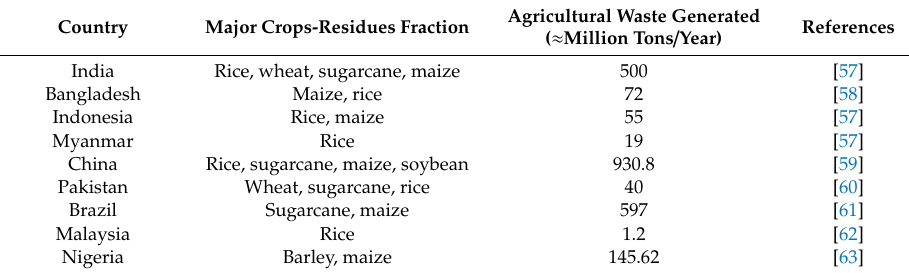
Table 4. Major agricultural residues generated annually in di ff erent